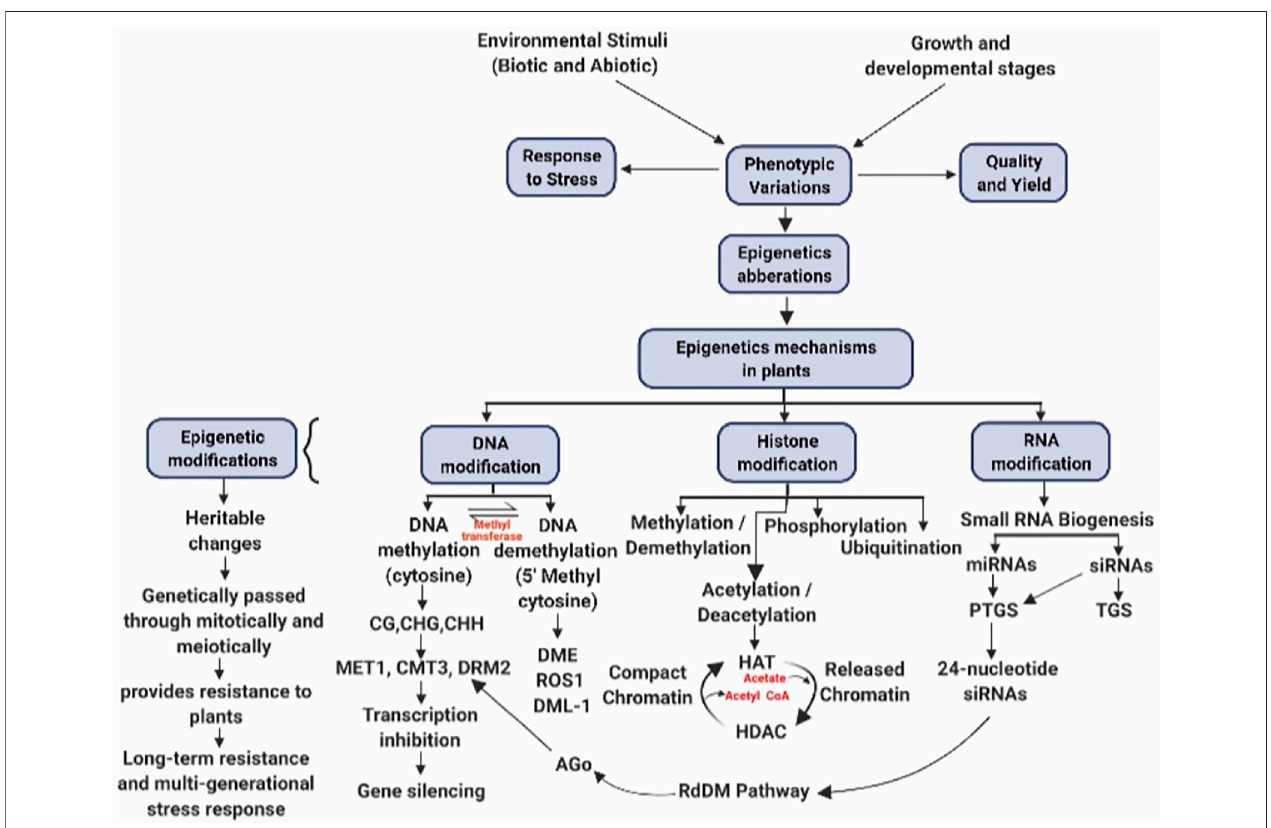
FIGURE 1 | Epigenetic changes in response to stress management during growth and development of